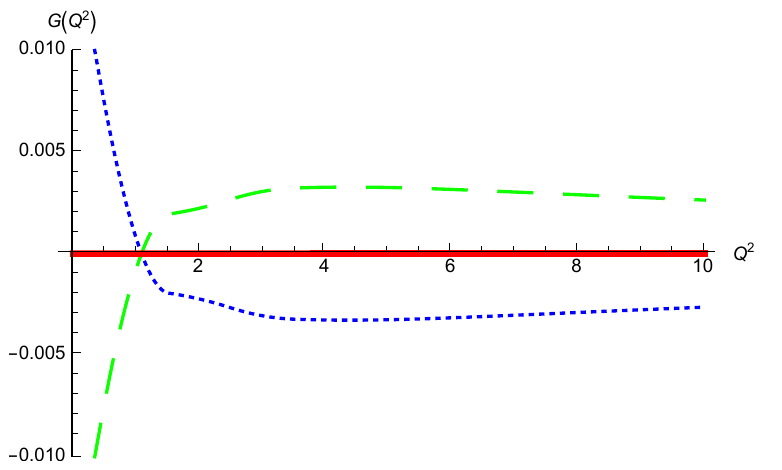
Figure 18. Contributions to the form factor G ( Q 2 ) of the transition between the states Nos. 2 and 3 from Table 1. The dotted line is G 00 ( Q 2 ) , and the dashed line is G 10 ( Q 2 ) (for their definitions, see the text). The their sum (solid line) is the full form factor G ( Q 2 ) . (Adapted from